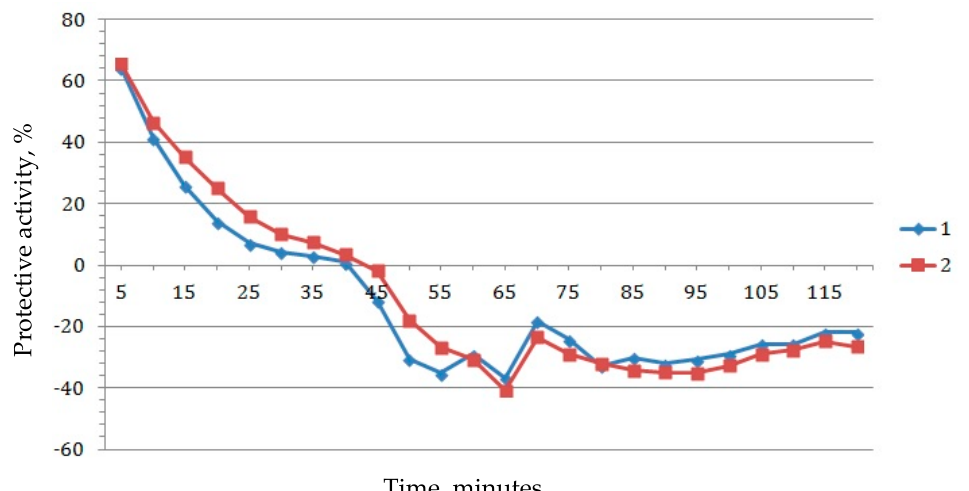
Figure 5. Protective effect time dependency for C 60 in TWEEN 80 2% at concentrations 10 − 5 (1) and 10 − 4 (2) g/l.